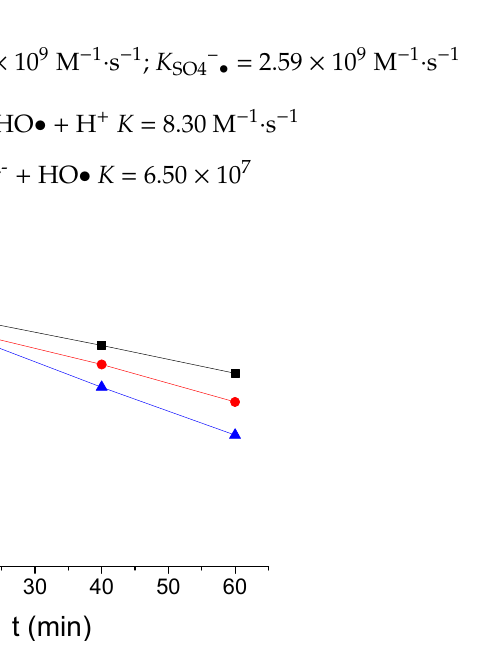
Figure 3. The ATZ removal rate under a different pH ( C 0 = 1.25 μ mol/L).